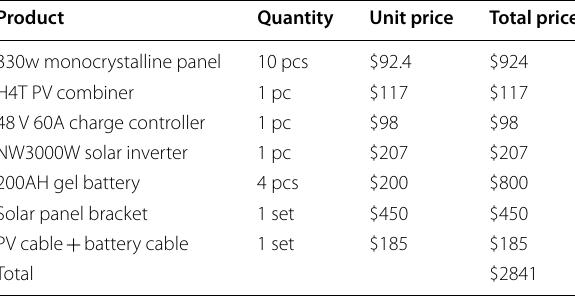
Table 1 Description of a stand-alone solar power supply system